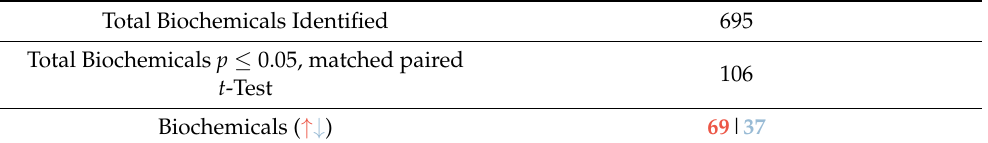
Table 3. Untargeted metabolomic compound identification and statistical comparison.